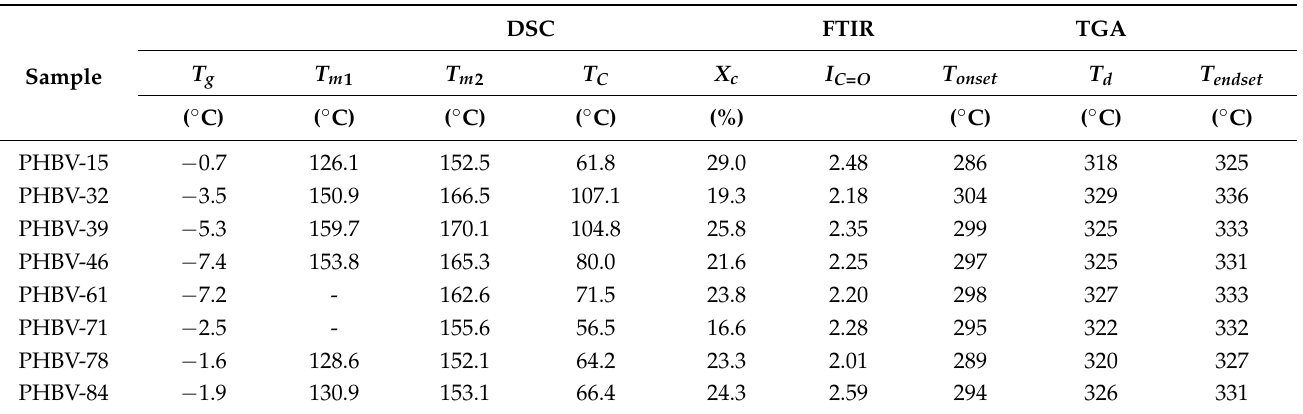
Table 4. Physical and thermal properties of purified PHBV obtained from CHCl 3 extraction of